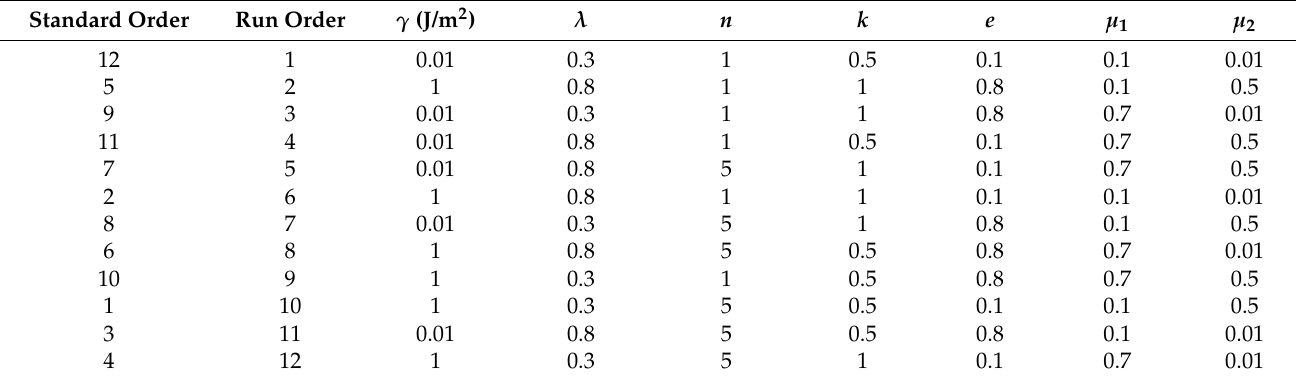
Figure 3. Angle of repose of piling